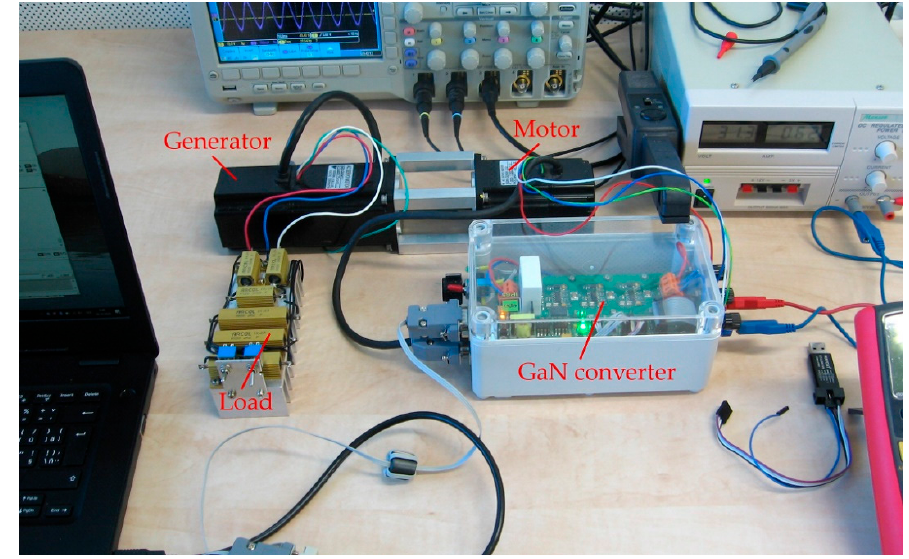
Figure 7. Experimental workspace.